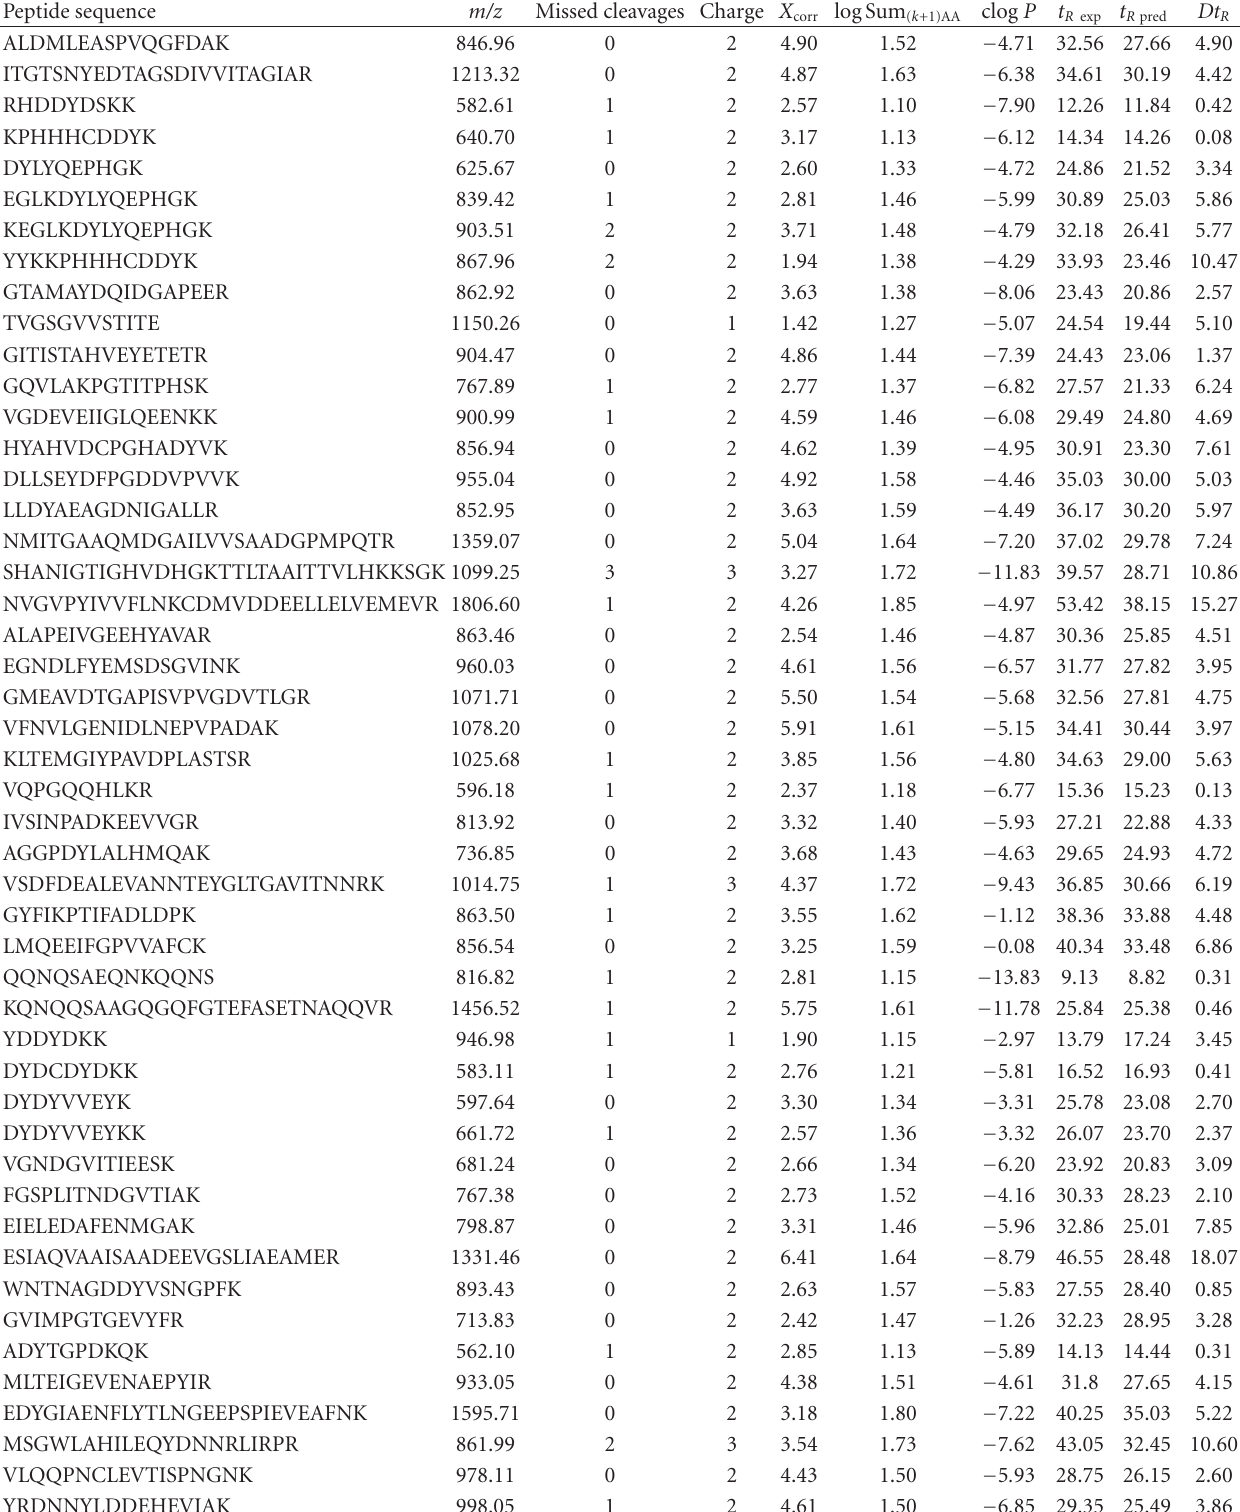
Table 3: Test peptides from proteins of Bacillus subtilis proteome, identified on the basis of more than one peptide with X corr above 1.5. Peptide